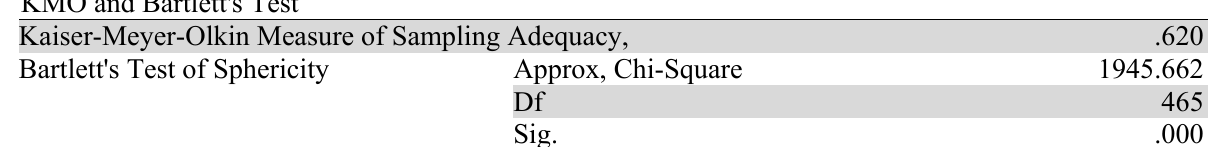
KMO and Bartlett's Test Kaiser-Meyer-Olkin Measure of Sampling Adequacy, .620 Bartlett's Test of